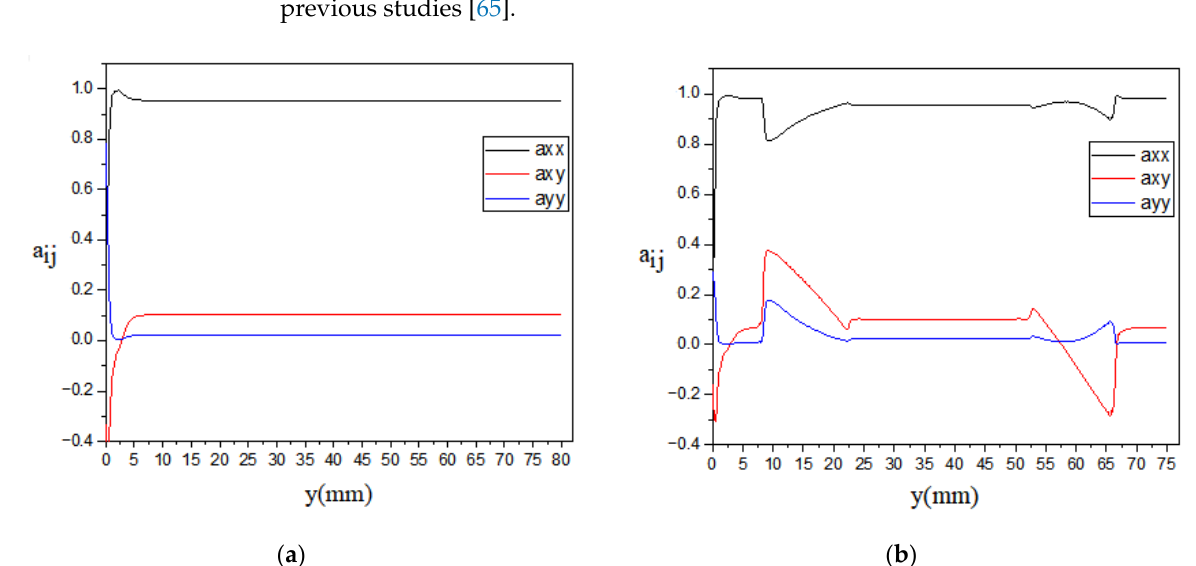
Figure 12. Evolution of second-order orientation tensor components ( a xx , a xy a yy ) along with a streamline very close to the vertical wall ( a ) for rectangular and ( b ) dog bone samples.